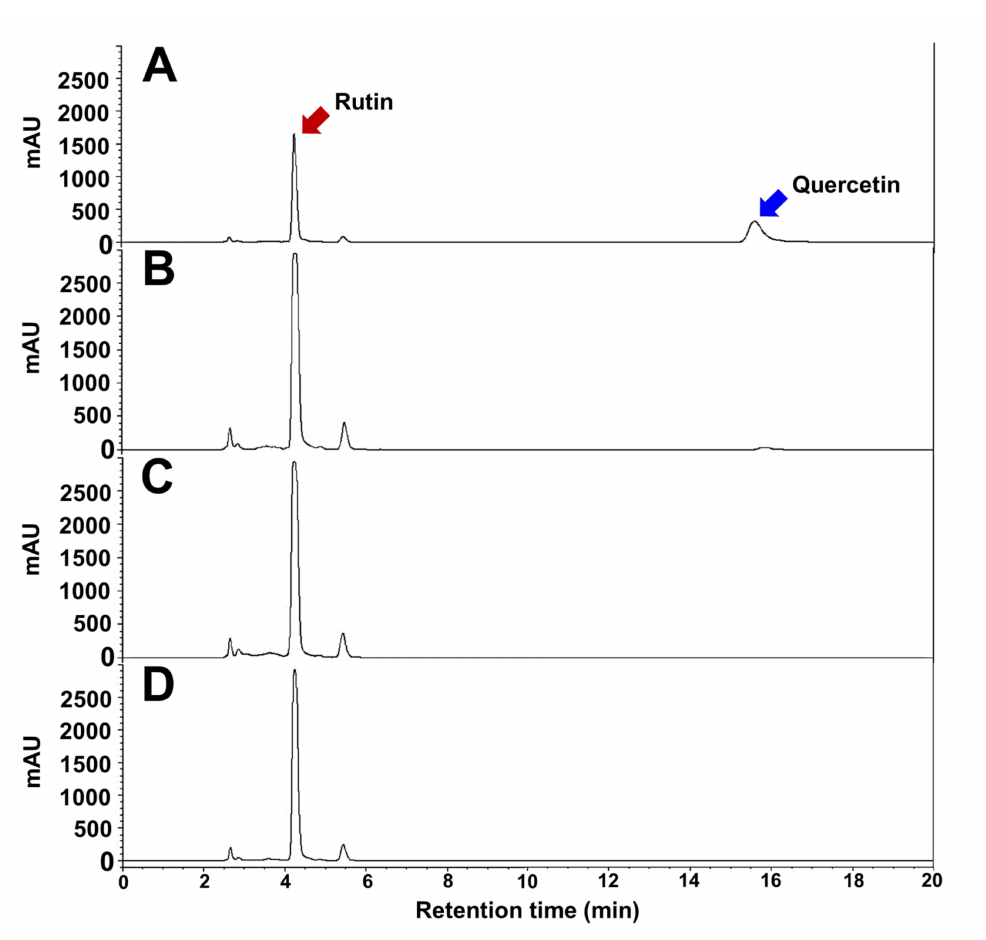
Figure 1. HPLC chromatograms of ( A ) native, ( B ) autoclaved, ( C ) boiled, and ( D ) steamed